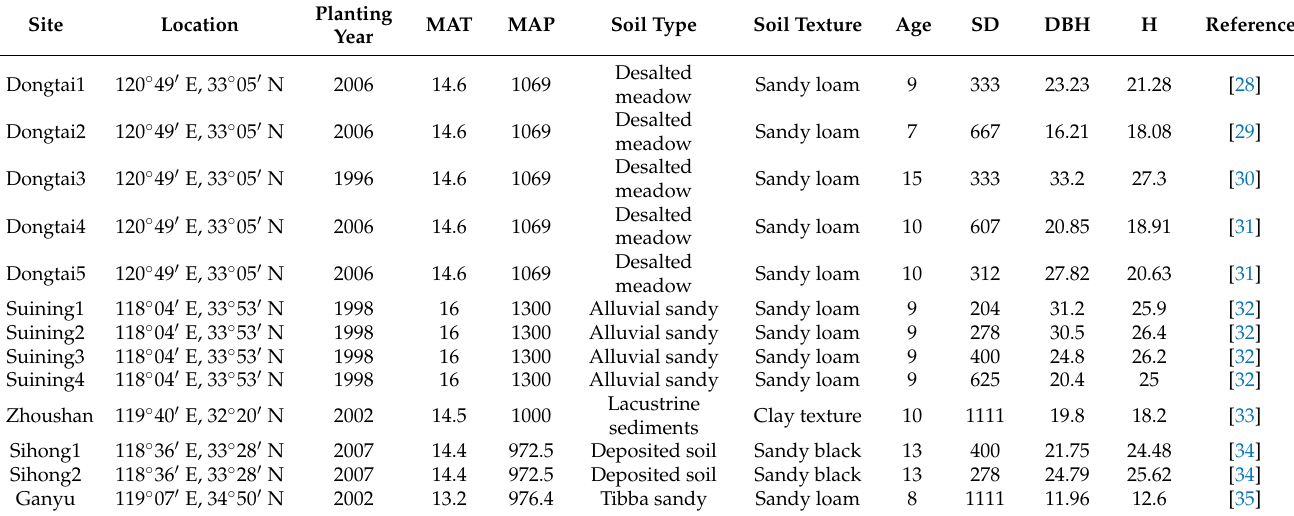
Table 1. Stand, climate, and soil characteristics of the sampling sites in northern Jiangsu